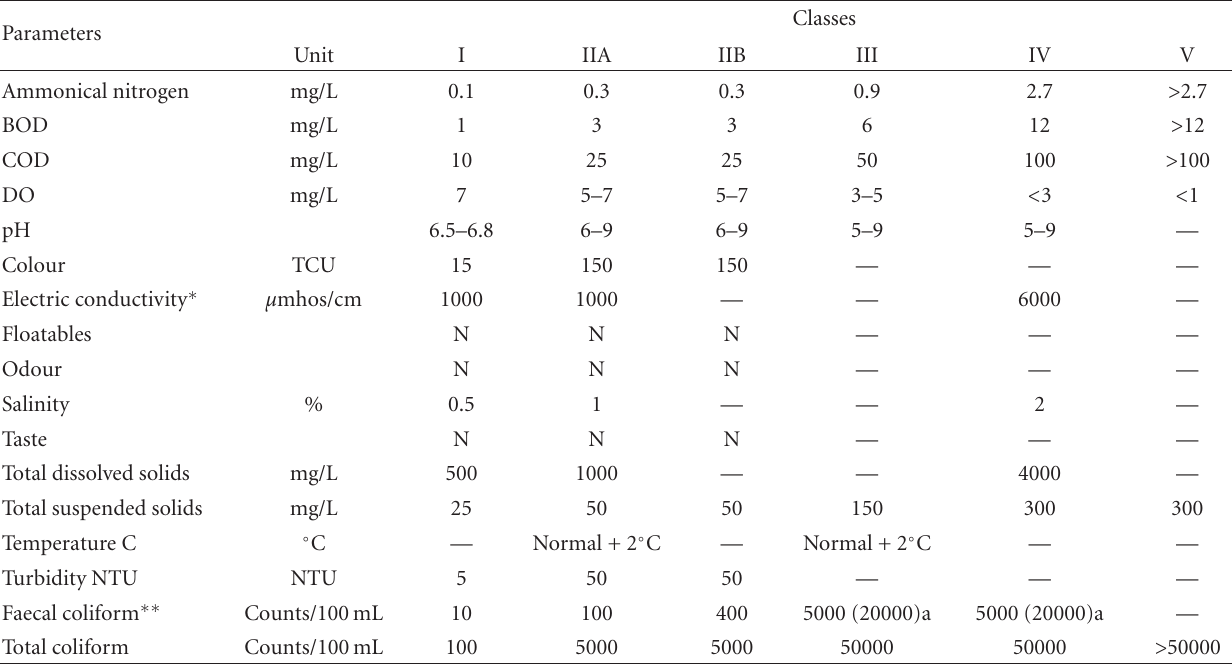
Table 4: Interim National Water Quality Standards for Malaysia (INWQS) (2008).